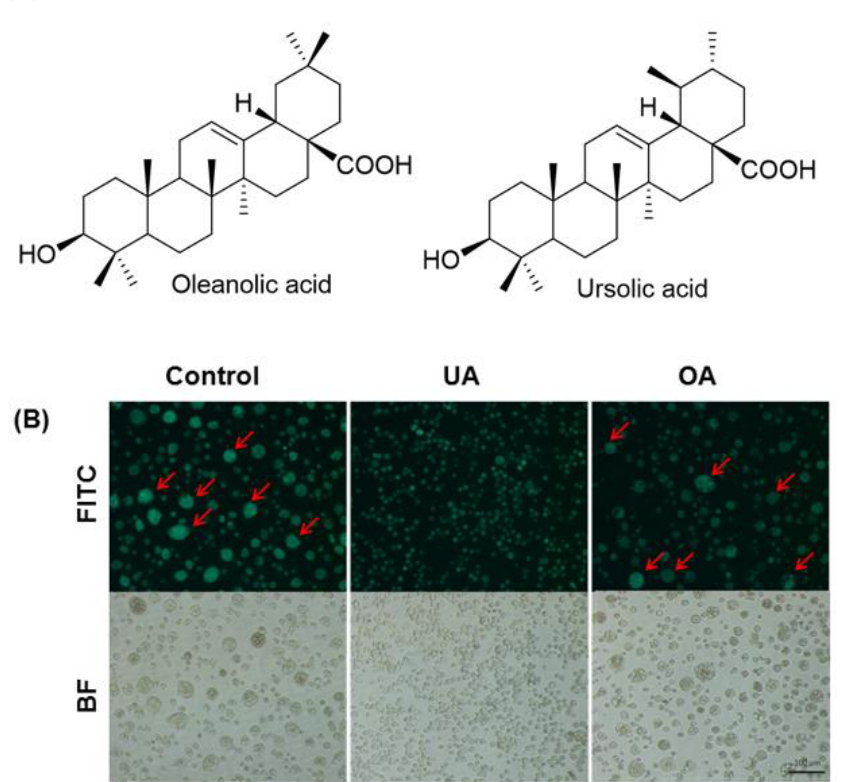
Figure 5. ( A ) Chemical structure of oleanolic acid (OA) and ursolic acid (UA). ( B ) Evaluation of the effects of UA and OA on CHIKV 26S-mediated Sf21 cell fusion. The Sf21 cells were infected with recombinant baculovirus vAc-CHIKV26S-Rhir-EGFP at multiplicity of infection (MOI) of 10. After 1 dpi, the infected cells were treated with 100 μM UA and OA. The arrows shows syncytial formation at 2 dpi was examined under a fluorescence microscope with a FITC channel (upper panel) and a bright field (lower panel). The bar represents 100 µm.